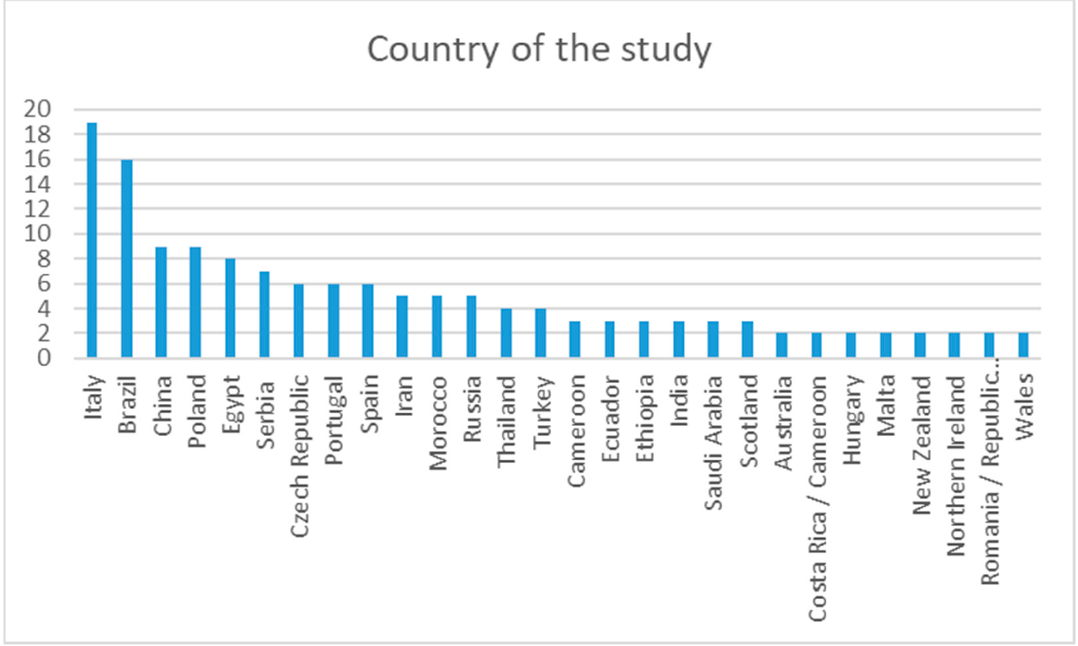
Figure 4. Graph showing the number of studies related to geoheritage, geoconservation and geotourism worldwide, with respect to the 169 articles analyzed.